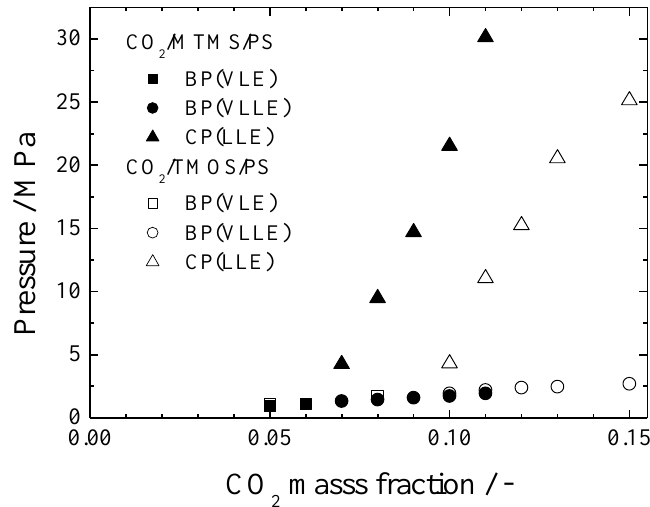
Figure 6. Comparison between CO 2 /MTMS/PS and CO 2 /TMOS/PS ternary systems (313.2 K, M W = 35,000, silicon alkoxide:PS = 9:1). Table 6. Hildebrand solubility parameters of the pure components.